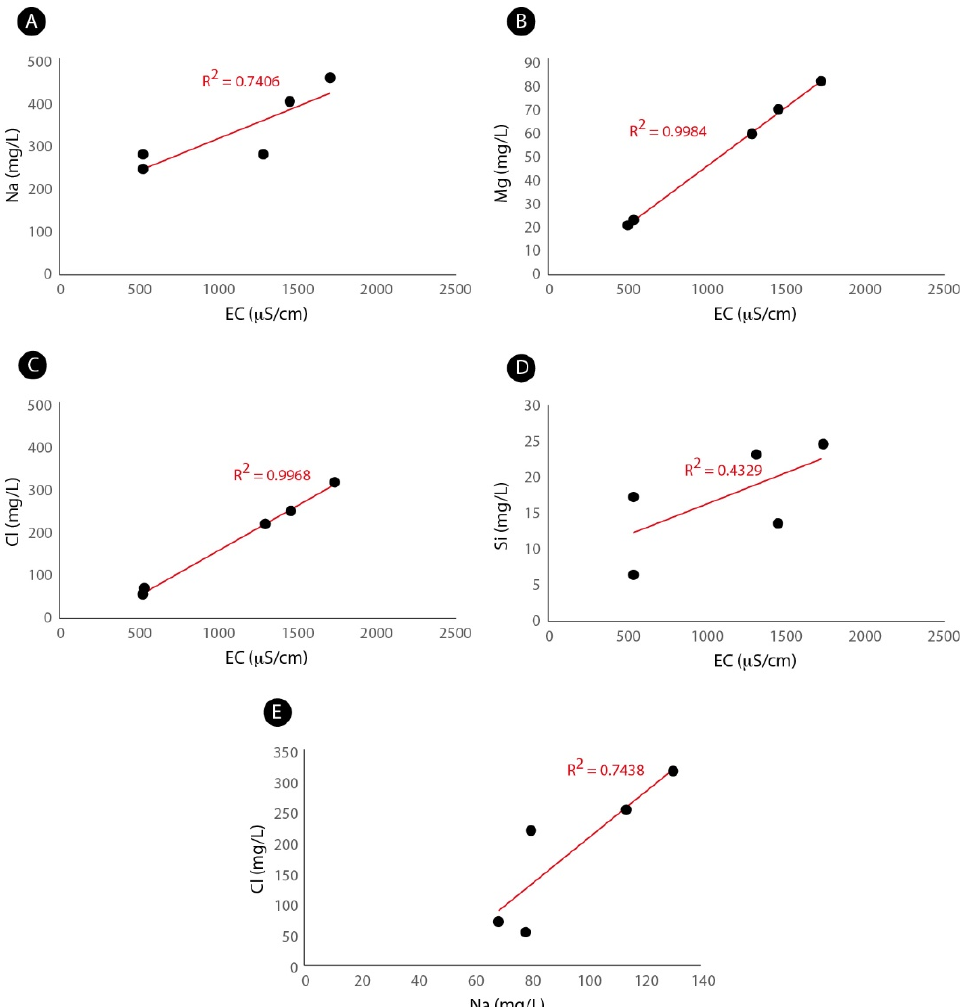
Figure 10. Relations between electrical conductivity (EC) and major ions in the S. Miguel river sub-basin. ( A ) EC–Na; ( B ) EC–Mg; ( C ) EC–Cl; ( D ) EC–Si; ( E ) Na–Cl.